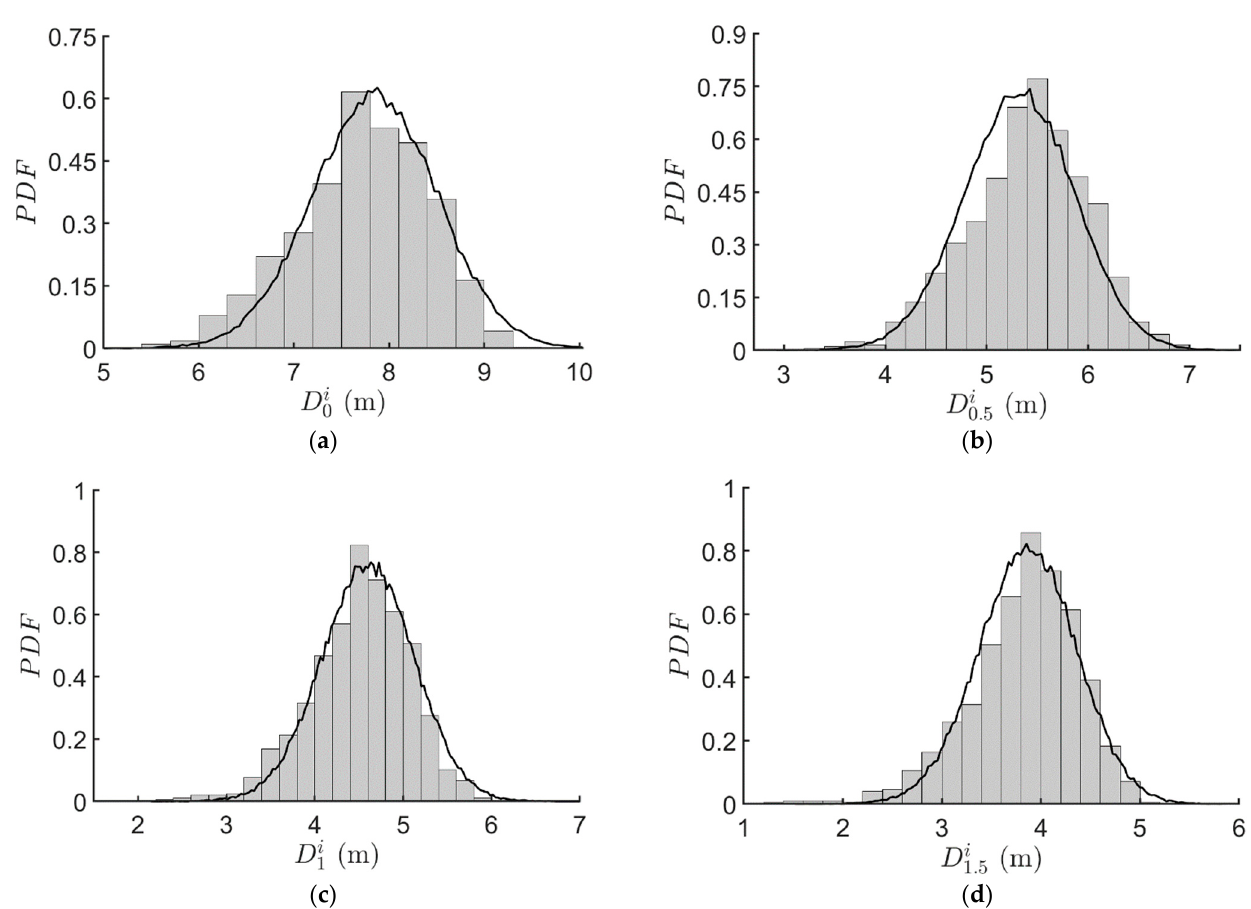
Figure 21. The estimated probability density function of influence distance (histogram: 1000 samples with brute-force simulations; solid line: 10 5 samples, evaluated with the machine-learning model): ( a ) PDF of D i ; ( b ) PDF of D i ; ( c ) PDF of D i ; ( d ) PDF of D i 0 0.5 1 1.5